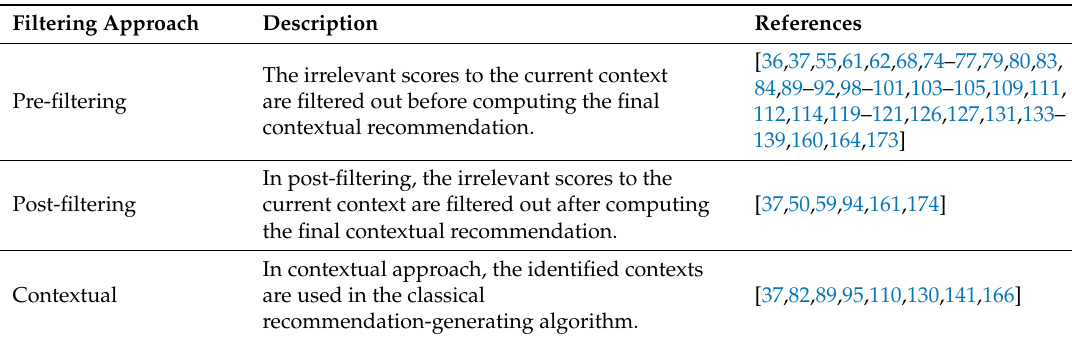
Table 4. Filtering approaches.